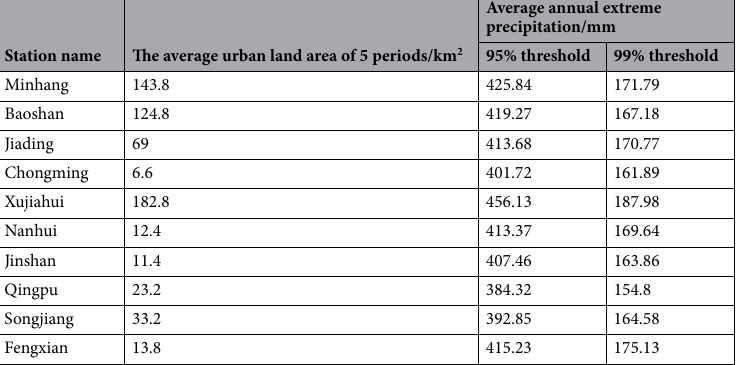
Table 7. Average urban land area and average annual extreme precipitation for 5 periods within 10 km of each station.